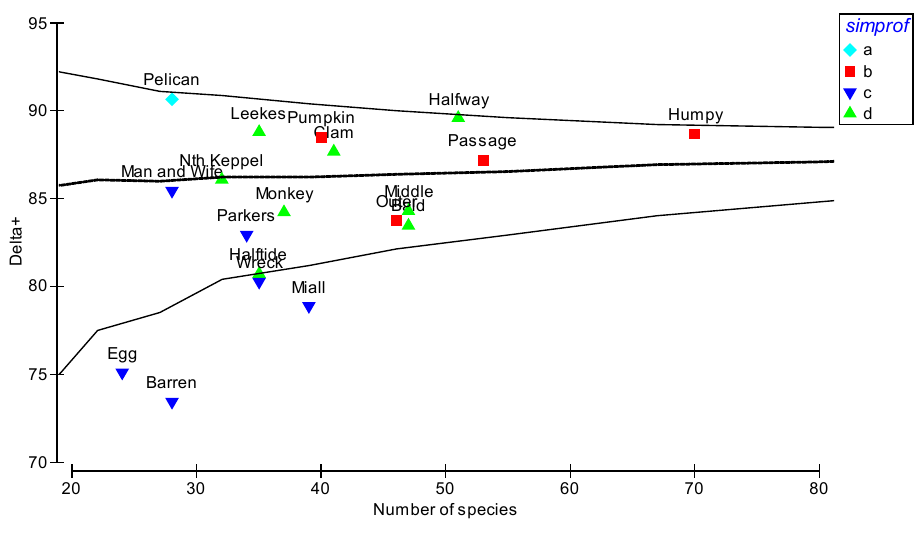
Figure 6. Funnel plots for simulated Δ+ versus species numbers. The broken line indicates the mean Δ+ for the full species inventory and thin lines represent the 95% probability limits. Aqua symbols = group A sites, Red = group B sites, Blue = group C sites and Green = group D